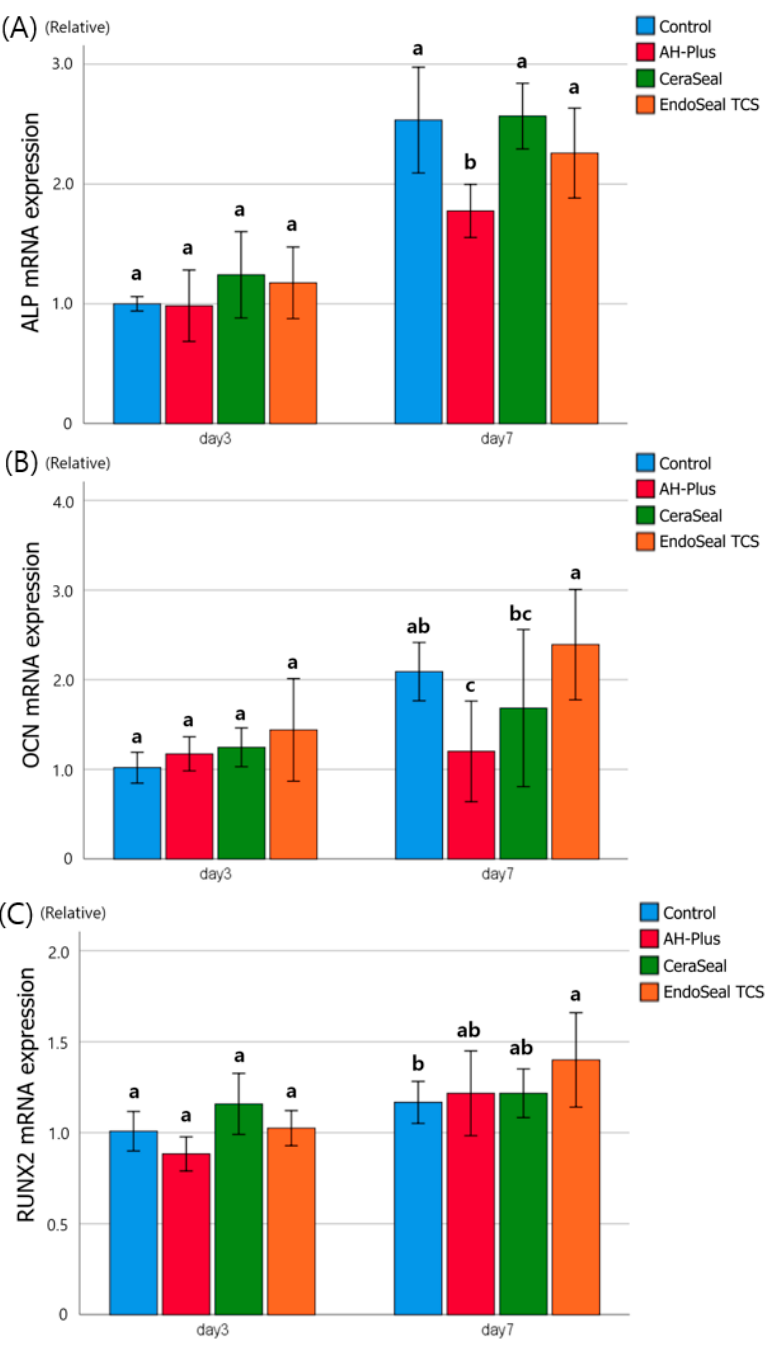
Figure 4. The effects of sealers of hPDLSCs on the relative mRNA expression. ( A ) ALP, ( B ) OCN, and ( C ) RUNX2 measured with RT-qPCR and normalized with β -actin. Different alphabets indicate that there is a difference between the materials within the same time group ( p < 0.05).